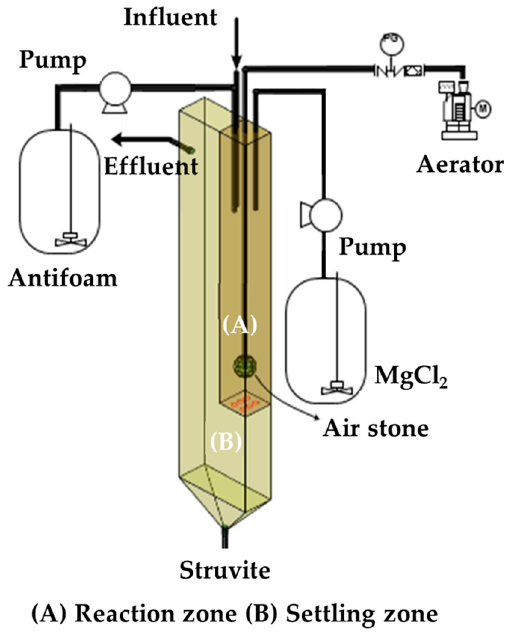
Figure 2. Schematic of the struvite production unit.